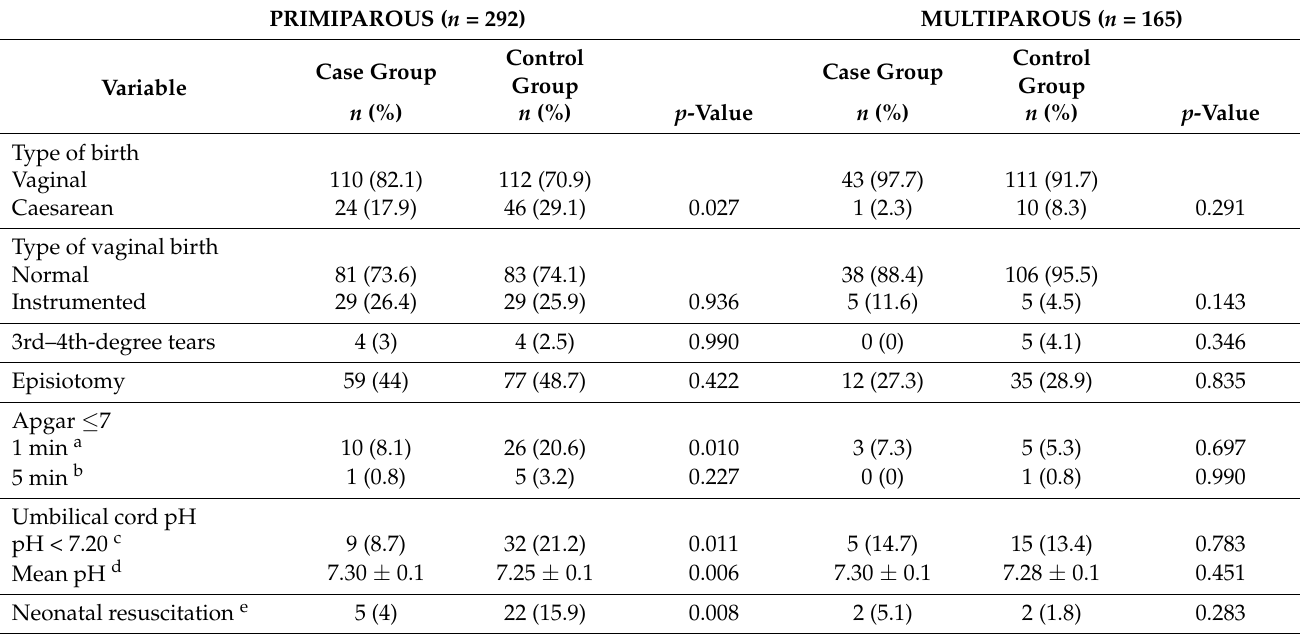
Table 2. Obstetric and neonatal results of women with and without birth plans. PRIMIPAROUS ( n = 292) MULTIPAROUS ( n =